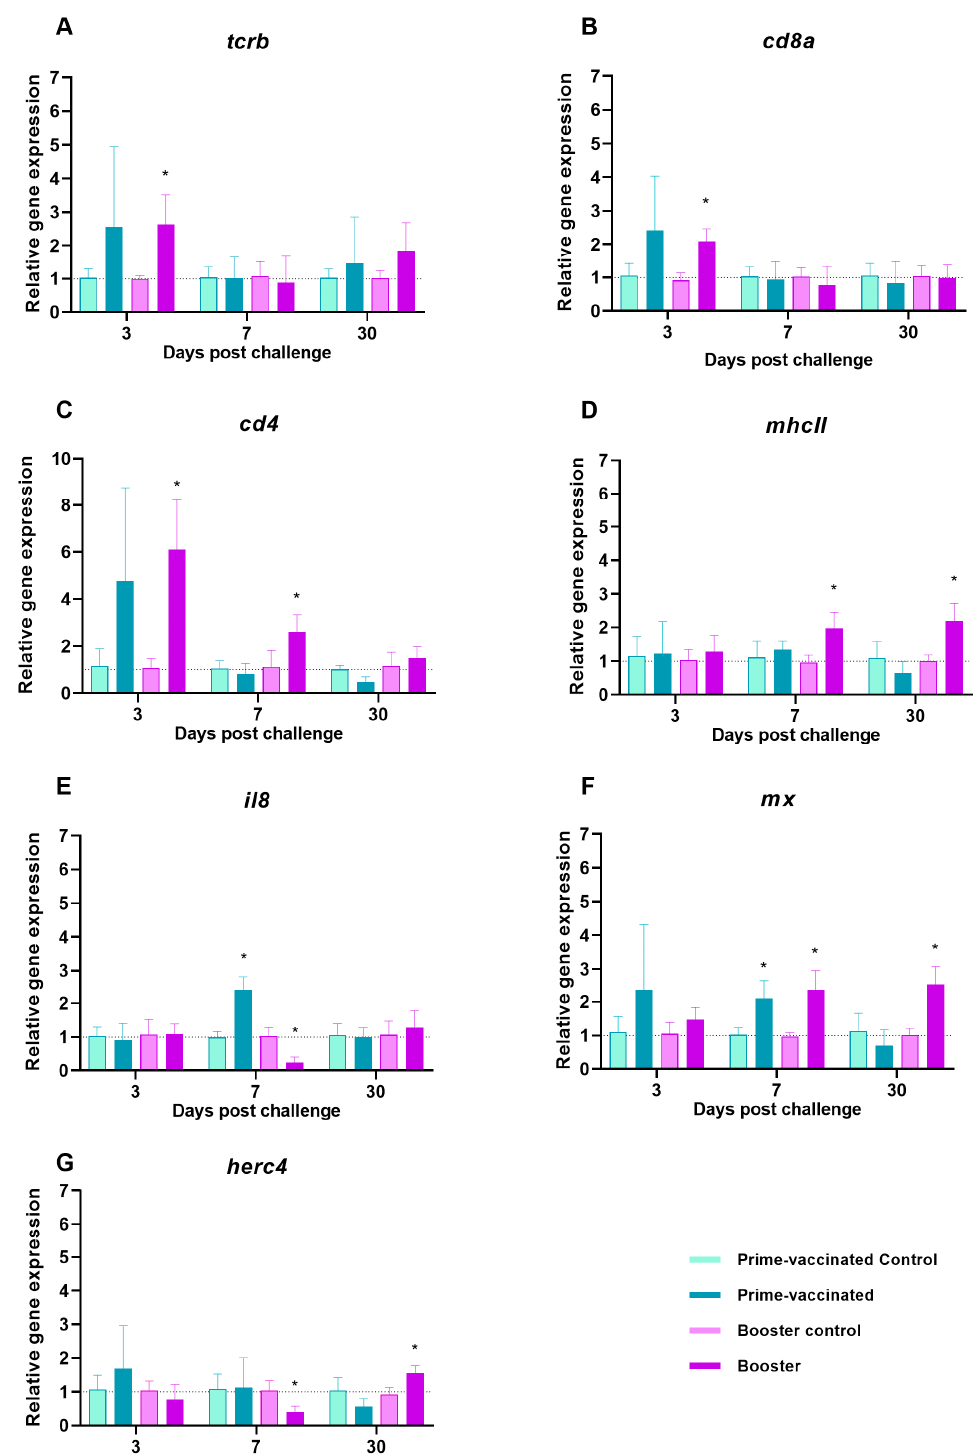
Figure 7. Expression of immune-related genes ( A ) tcrb , ( B ) cd8a , ( C ) cd4, ( D ) mhcII , ( E ) il8 ; ( F ) mx and ( G ) herc4 , in the head-kidney of Senegalese sole specimens at 3-, 7-, and 30-days post challenge (dpc). Challenge was performed by intramuscular injection with 2 × 10 3 TCID 50 /g for prime- and booster-vaccinated fish, respectively. Data represent the mean ± standard deviation (n = 6 fish/group and time). Asterisks represent statistical differences between control and prime-vaccinated/booster groups ( p < 0.05).